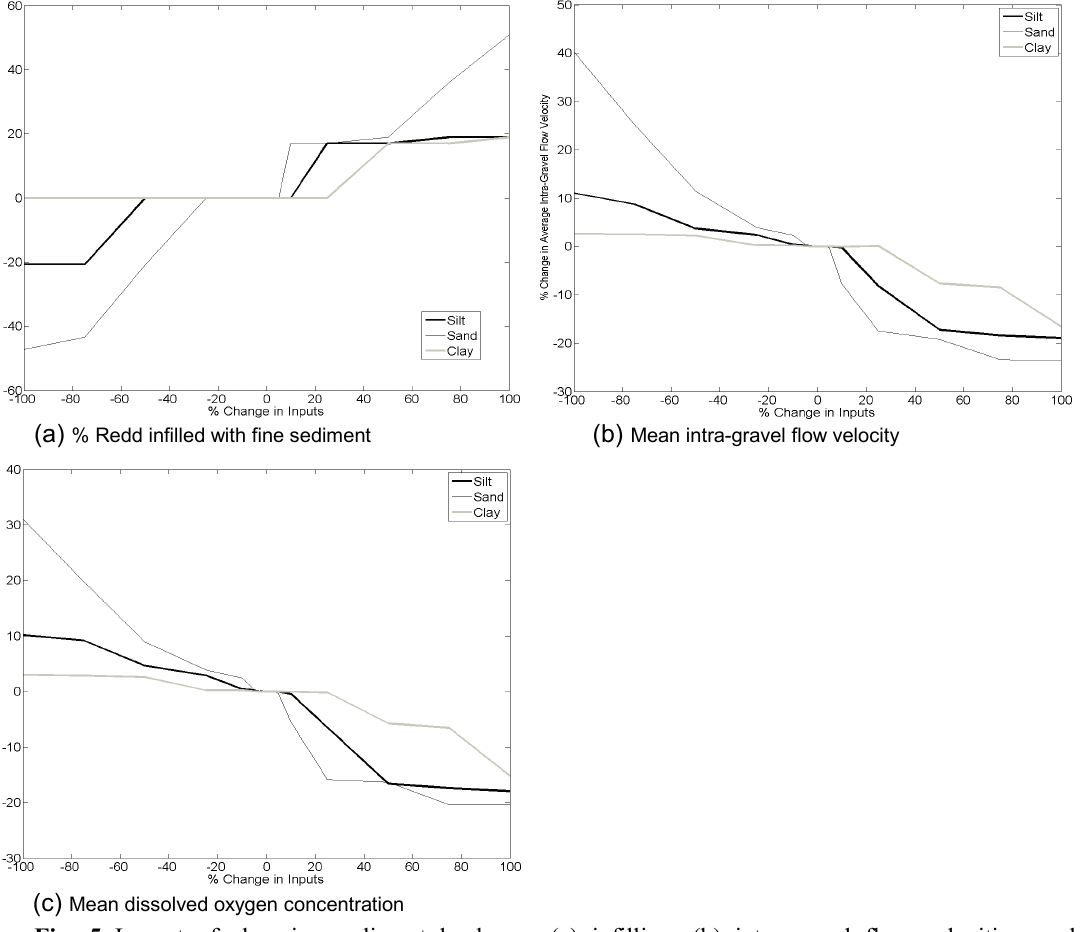
Fig. 5 Impact of changing sediment loads on: (a) infilling; (b) intra-gravel flow velocities; and (c) dissolved oxygen